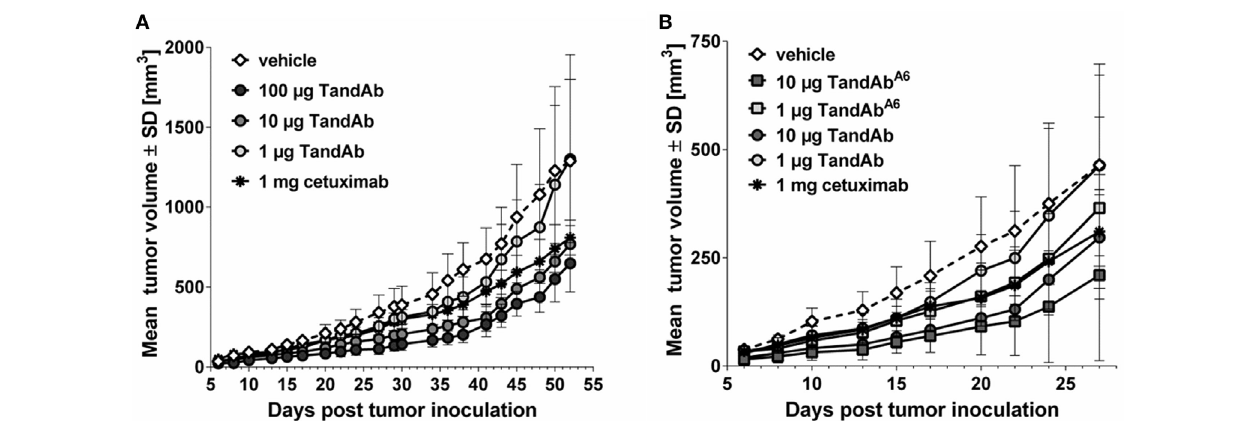
FigUre 6 | egFrviii-binding antibodies reduce the growth of F98 egFrviii xenograft tumors in mice . NOD/scid mice were xenotransplanted by subcutaneous injection of 4 × 10 6 F98 EGFRvIII cells mixed with 1 × 10 7 human PBMC on day 0. Tandem diabody (TandAb) or vehicle was dosed intravenously as indicated 2 h post-tumor cell inoculation and on four subsequent days. Cetuximab was dosed intraperitoneal twice a week with 1 mg starting on day 0. (a) Dose-dependent tumor growth inhibition by EGFRvIII Li3G30 /CD3 x TandAb (containing the non-affinity optimized EGFRvIII-binding domain Li3G30). Statistical analysis (two-way repeated measures ANOVA with Bonferroni posttests) was performed and showed significant differences between the vehicle group and the 100-µg TandAb-treated group on day 38, day 41 ( p < 0.05), day 43, and day 45 ( p < 0.01). (B) Comparison of subcutaneous F98 EGFRvIII xenograft tumor growth retardation by EGFRvIII Li3G30 /CD3 x TandAb and EGFRvIII A6 /CD3 x TandAb containing an affinity matured anti-EGFRvIII domain (A6) at two dose levels each. This study was terminated after 27 days